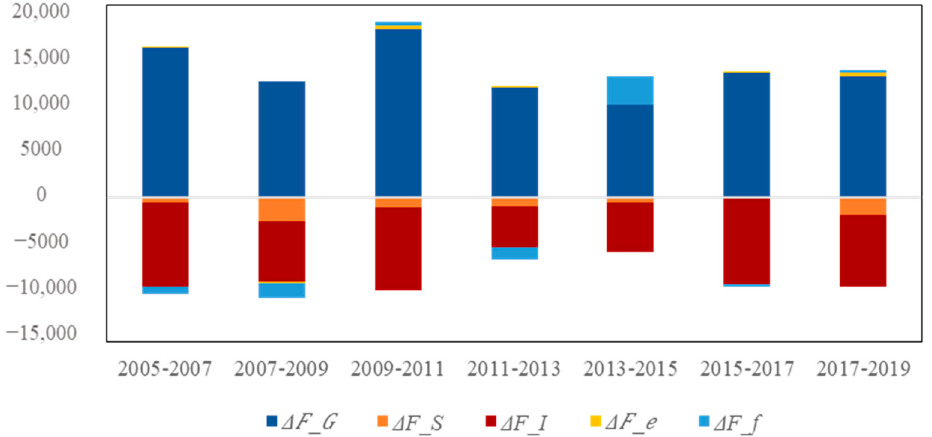
Figure 6. The impact of key factors on the consumption of petroleum